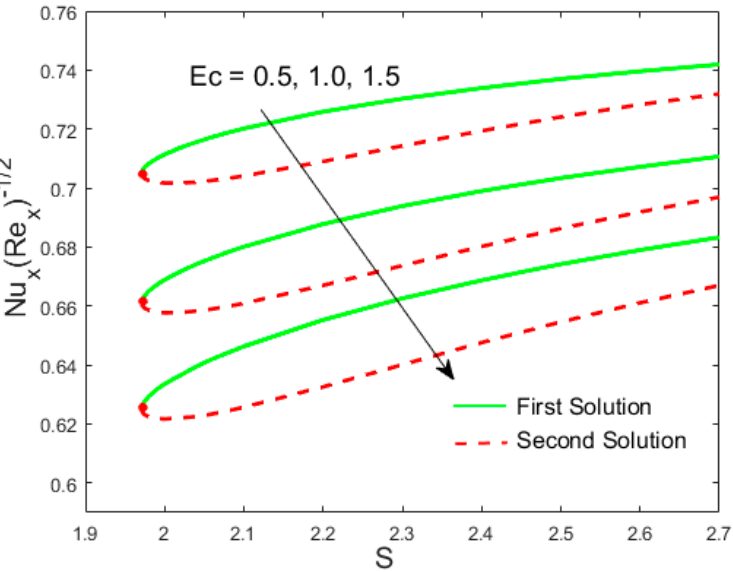
Figure 18. Influence of Ec versus S on Nu x Re